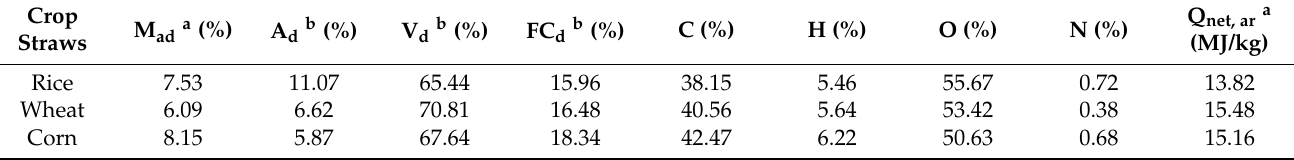
Table 1. Results of the industrial analysis and the major element analysis of the three crop straws. Crop